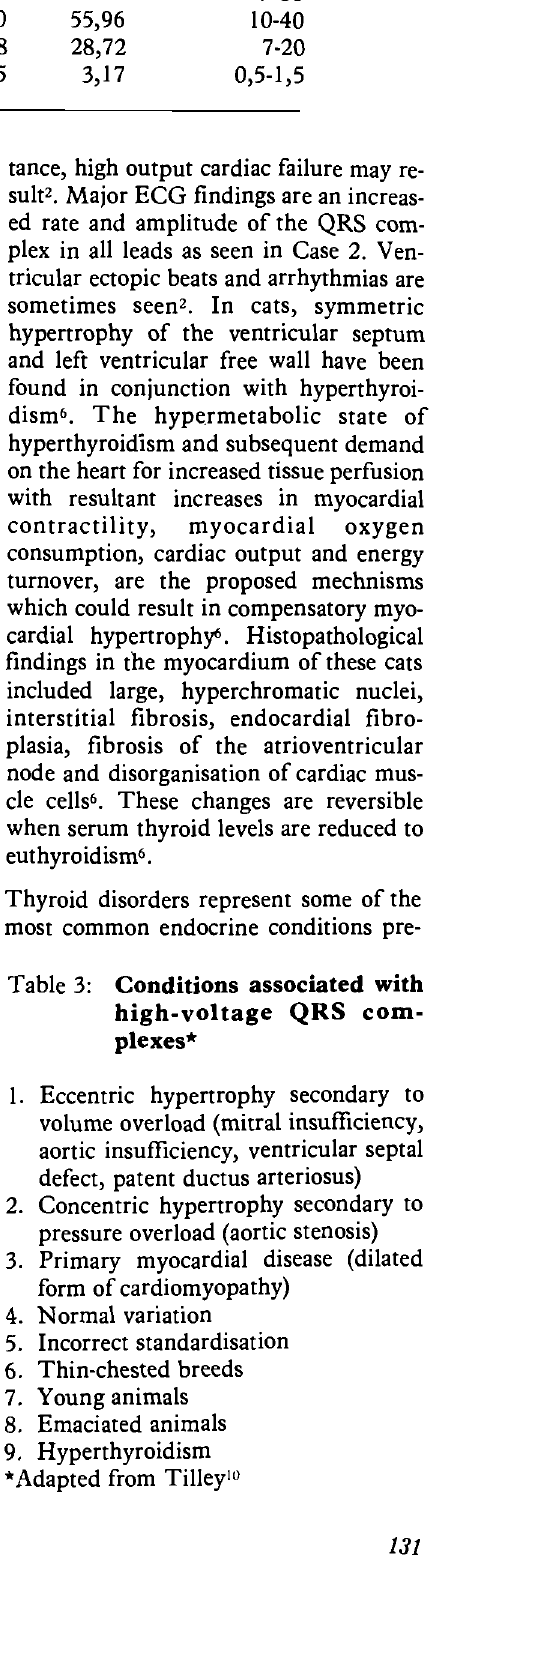
Fig. 1: Electrocardiographs of the